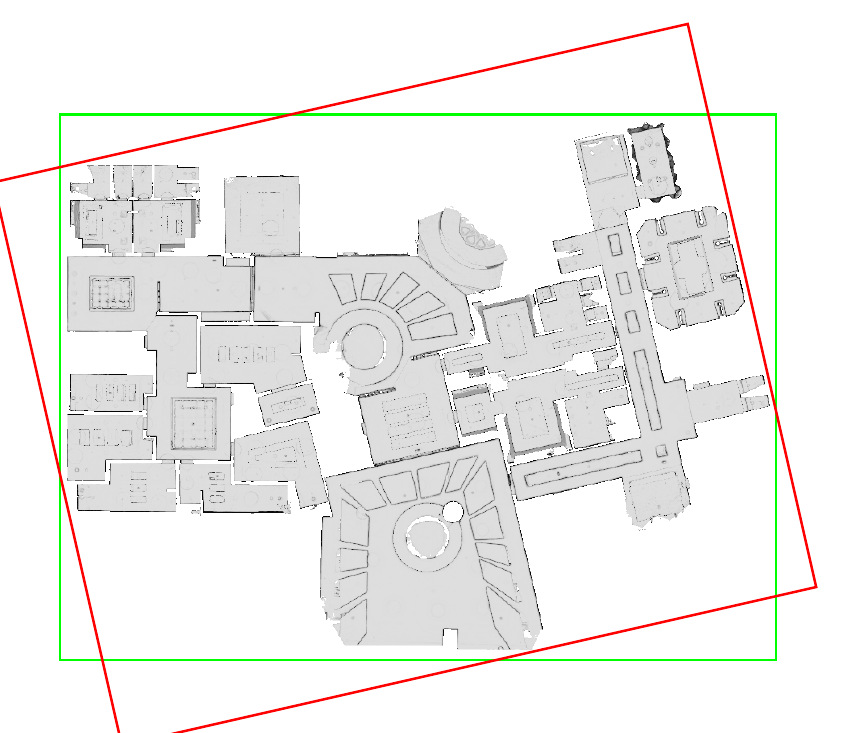
Figure 24. The green bounding box represents the horizontal alignment of the triangle mesh “ur6pFq6Qu1A” from Figure 15j as it is published in [90] and used as the ground truth pose for the evaluation results presented in Table 1. The red bounding box, on the other hand, represents the horizontal alignment resulting from our presented